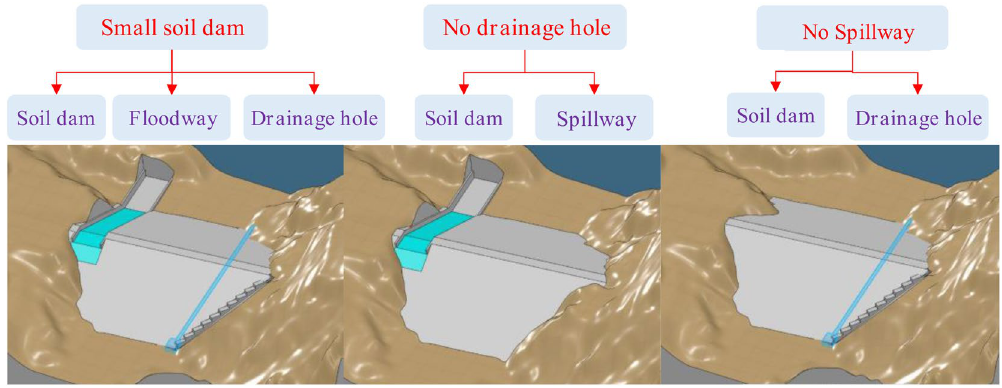
Figure 3. Structural types of traditional check